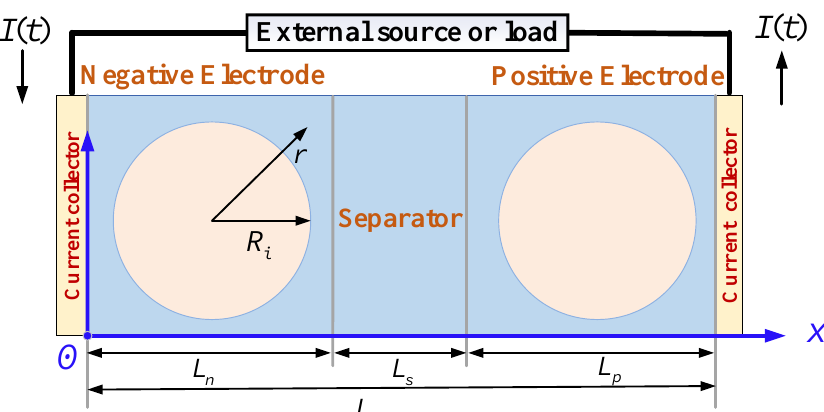
Figure 1. Schematic of the simplified EM for LIB.